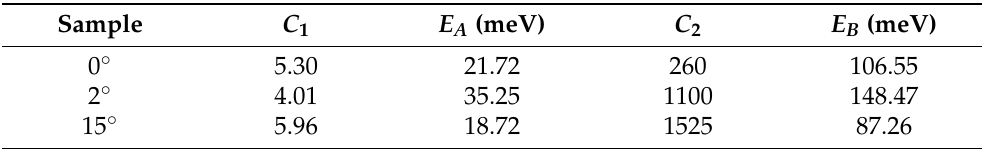
Figure 11. Temperature dependence of PL integrated intensities of the InGaAs/GaAsP QWs on substrates misoriented by ( a ) 0°, ( b ) 2°, and ( c ) 15°; the data are fitted using the Arrhenius model. An abnormal temperature-dependent PL intensity is observed in the sample with the 2°-misoriented substrate. Table 3. Parameters obtained by fitting the Arrhenius model for data representing samples with differently misoriented